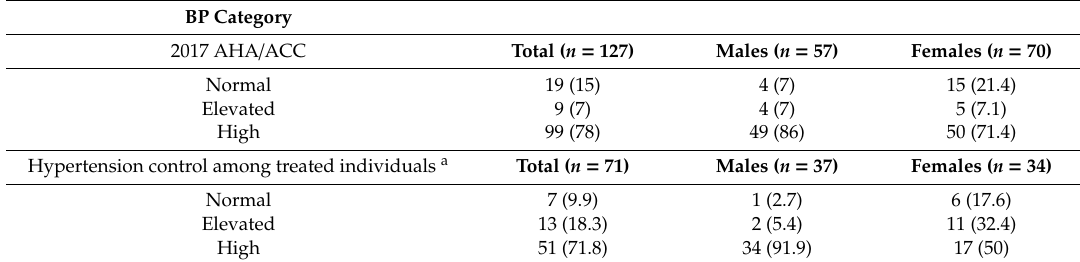
Table 4. Participants in the blood pressure